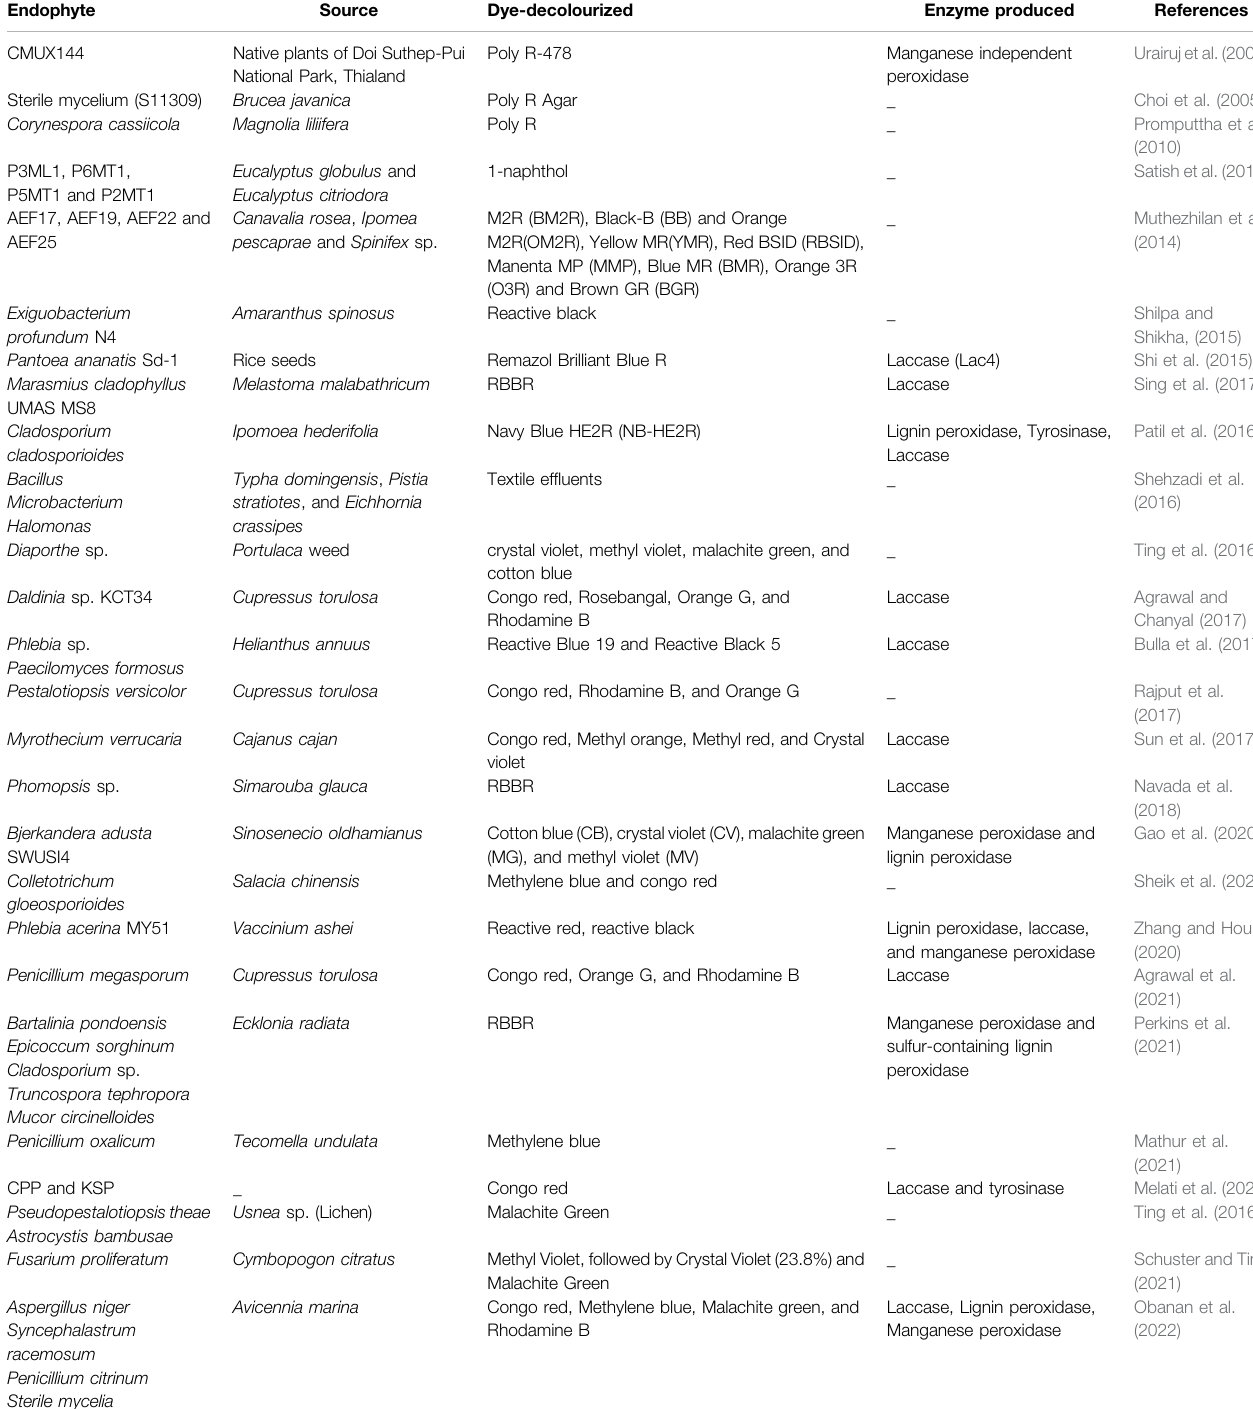
TABLE 3 | Endophytes capable of degrading and decolorizing aromatic